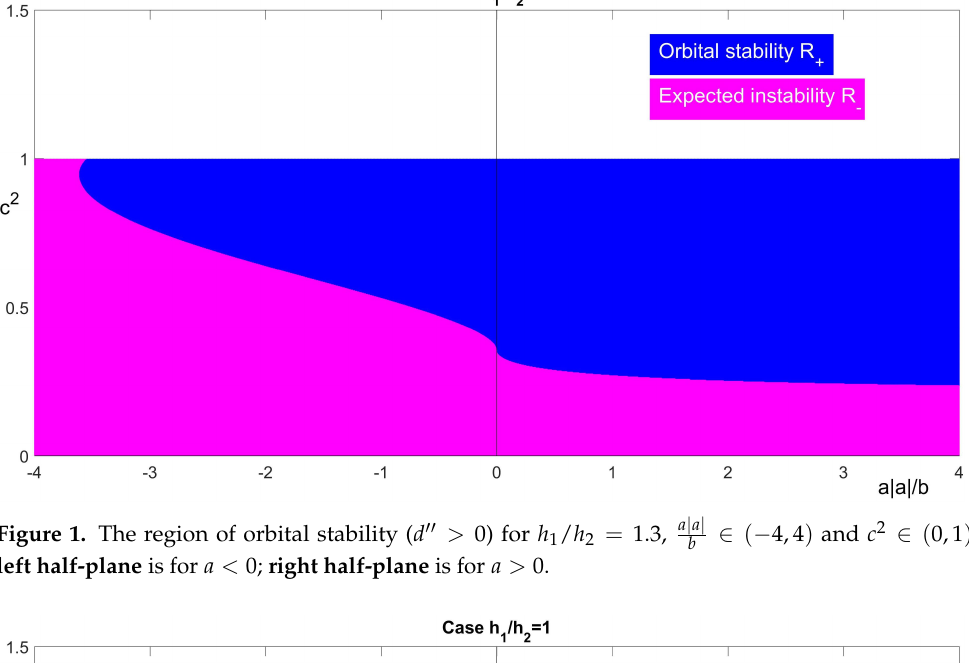
Figure 1. The region of orbital stability ( d (cid:48)(cid:48) > 0) for h 1 / h 2 = 1.3, a | a | left half-plane is for a < 0; right half-plane is for a > 0.